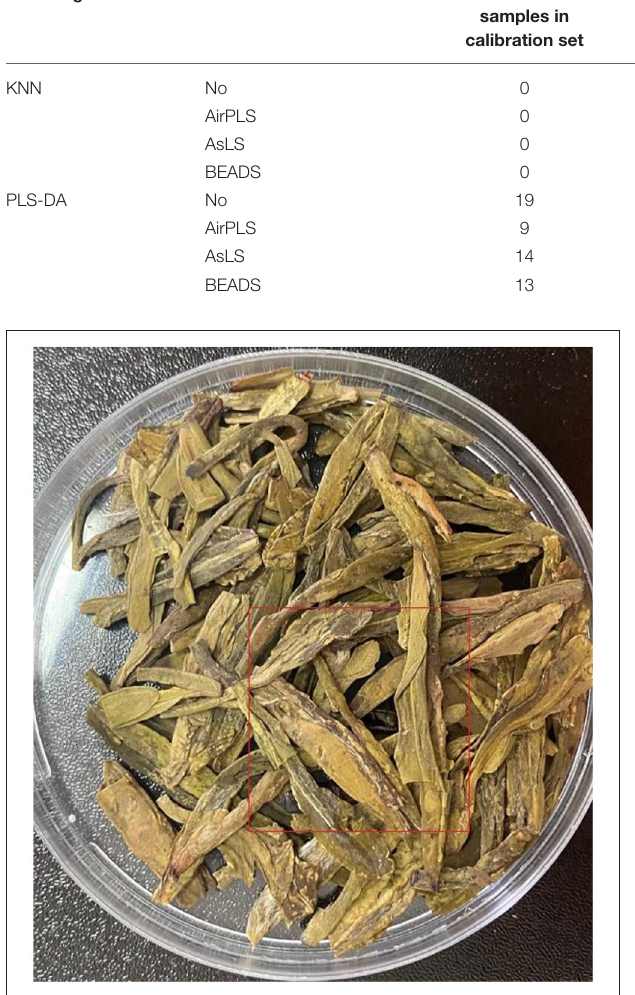
FIGURE 5 | RGB photo of the sample for THz image scan with insect foreign material embedded into the bottom of tea products.